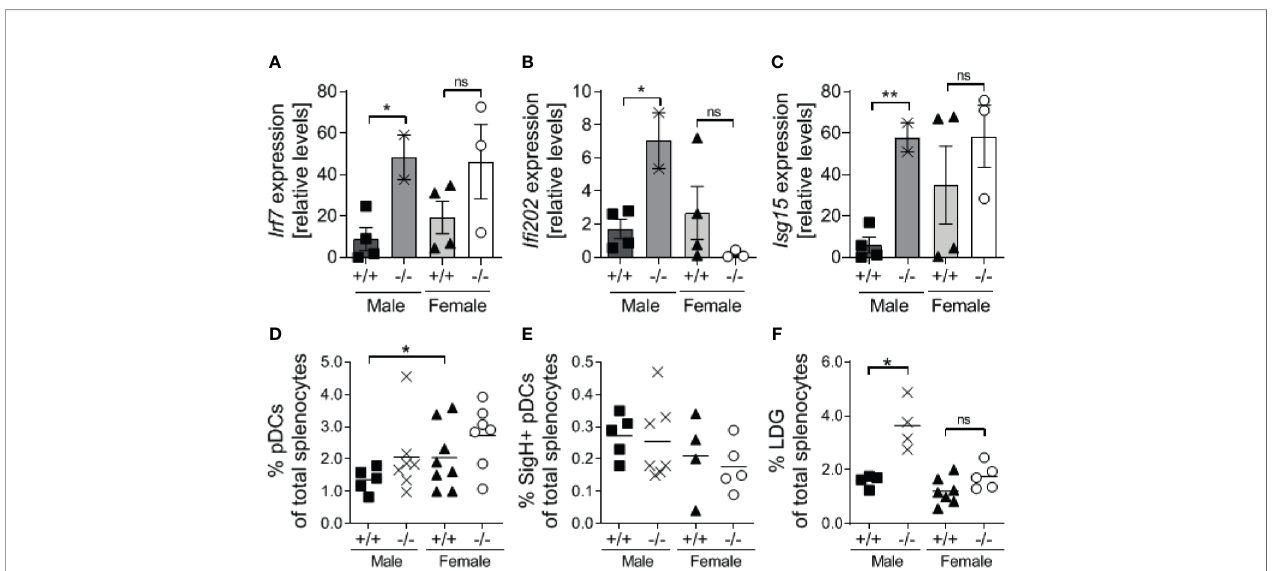
FIGURE 7 | Male S100a9-de fi cient BWF1 mice express elevated levels of mature neutrophils, but unaltered levels of BAFF. (A) Levels of Gr1 high CC11b + SSC high mature neutrophils was measured in spleens of male and female S100a9 +/+ , S100a9 +/- and S100a9 -/- mice by fl ow cytometry. (B) Serum BAFF levels were measured by ELISA on serum from 4 month old mice. Each dot represent one mouse. Shown is Mean ± SEM. *p < 0.05; **p < 0.01. One-way ANOVA: p < 0.05 (A) , p = 0.14 (B) .